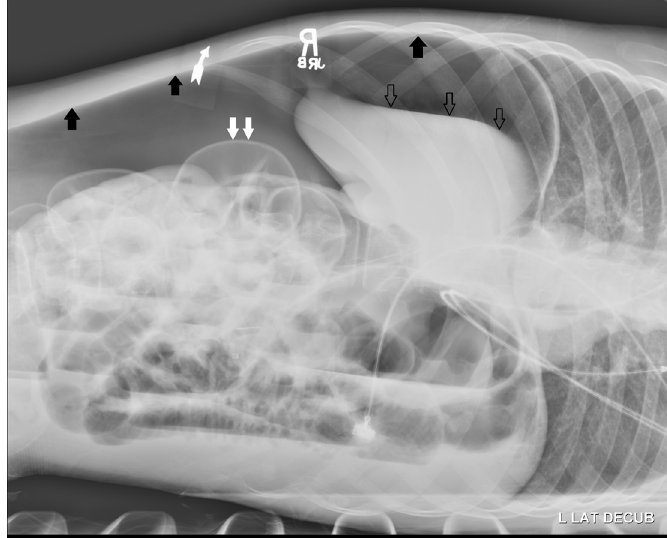
Figure 2. Initial abdominal film, in left lateral decubitus position demonstrating large amount of free air (black arrows), dilated loops of bowel (double white arrows) and inferior and medial displacement of the liver (“saddle bag sign” [triple clear arrows]).